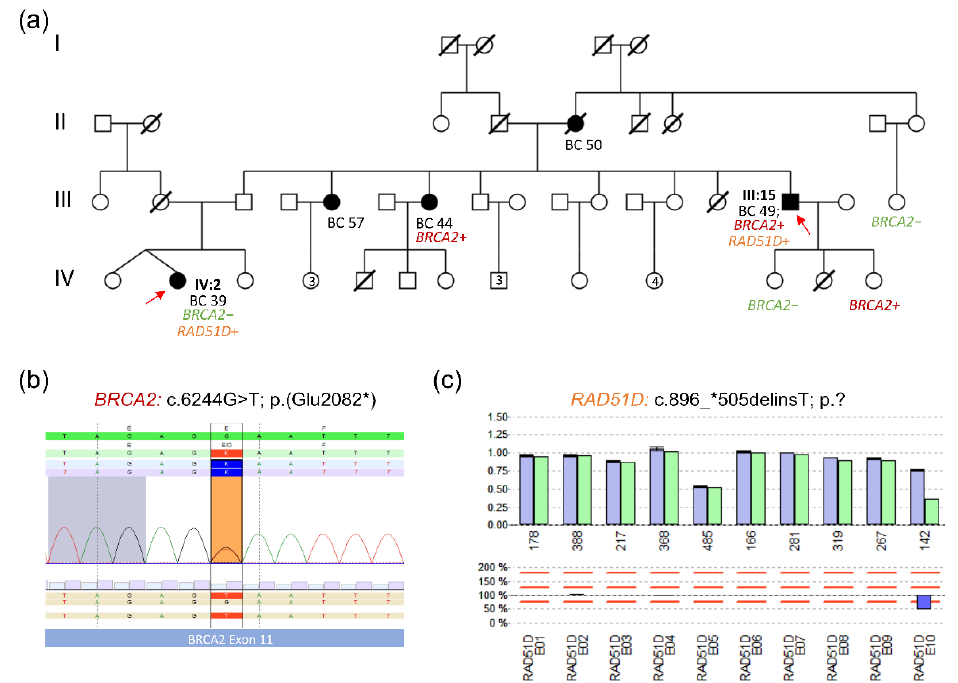
Figure 6. Identification of two different pathogenic germline variants in an HBOC family. ( a ) Pedigree of a family with carriers of pathogenic BRCA2 and RAD51D variants. I-IV indicate the different generations of the family. ( b ) NGS data showing the variant in BRCA2 : c.6244G > T; p.(Glu2082*). ( c ) Multiplex ligation-dependent probe amplification (MLPA) data showing a large deletion in RAD51D . Review of the NGS data specified heterozygosity for the RAD51D variant c.896_*505de- linsT.